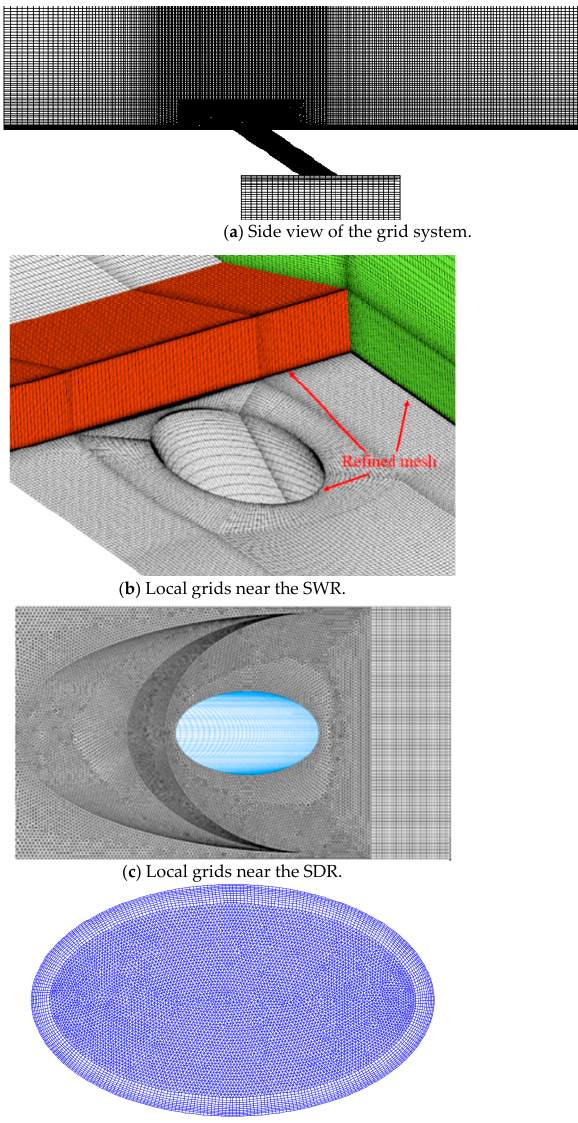
Figure 4. Schematic of representative computational meshes.